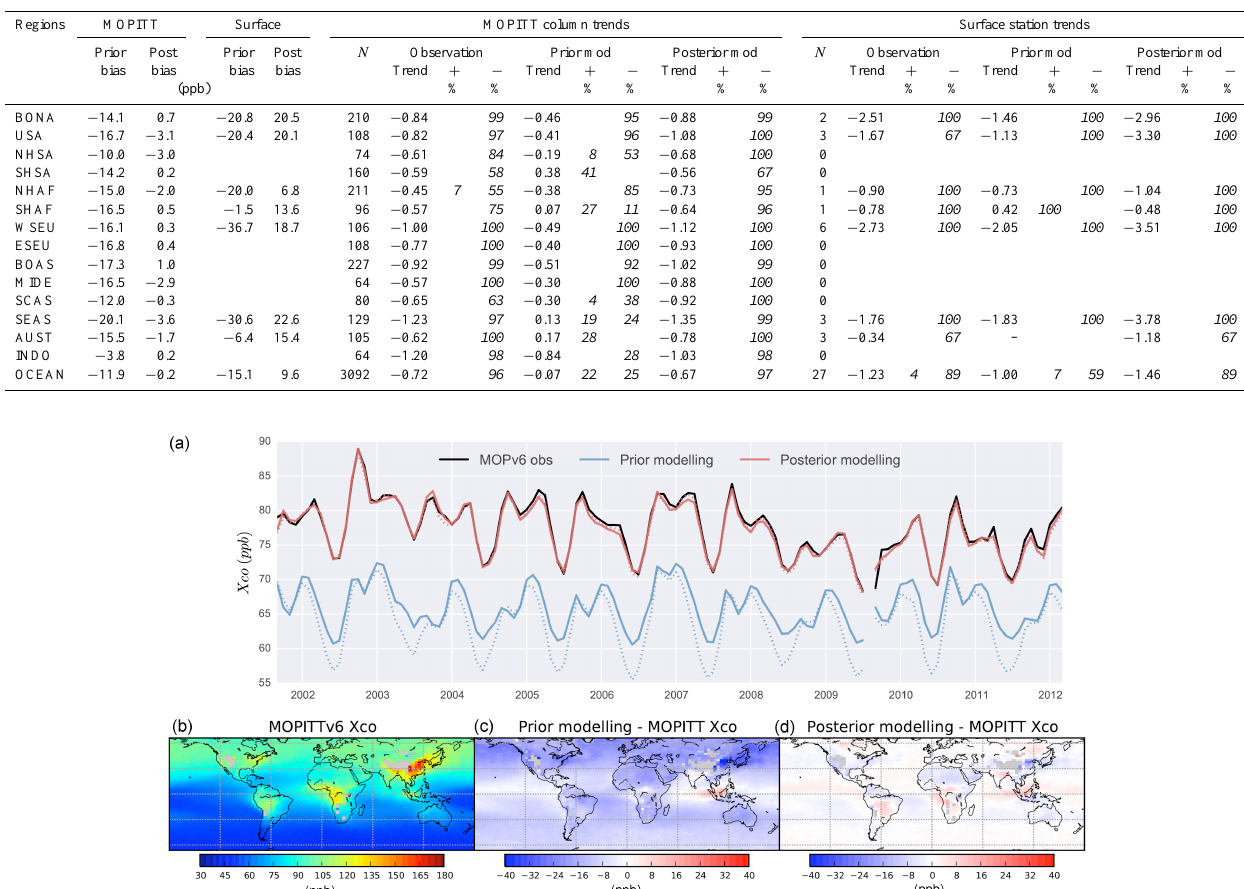
Figure 4. Time series and spatial distributions of the CO total column (X CO ) . (a) Time series of the global monthly mean mole fraction in the CO column. The black line represents satellite observation of MOPITTv6 X CO ; the blue (red) lines represent the prior (posterior) simulations. Solid lines represent the control version with TransCom-OH, and dotted lines represent the test with INCA-OH. (b) Distribution of multiyear mean annual X CO of MOPITTv6 retrieval. (c) Mean annual difference between the prior simulation and MOPITT. (d) Mean annual difference between the posterior simulation and MOPITT. Simulations shown in (c) and (d) used TransCom-OH. The results with INCA-OH show similar spatial distributions and are not shown